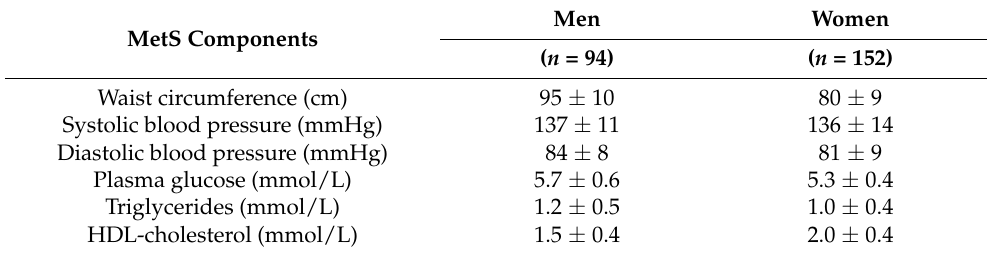
Table 1. Components of the metabolic syndrome (MetS) in older men and